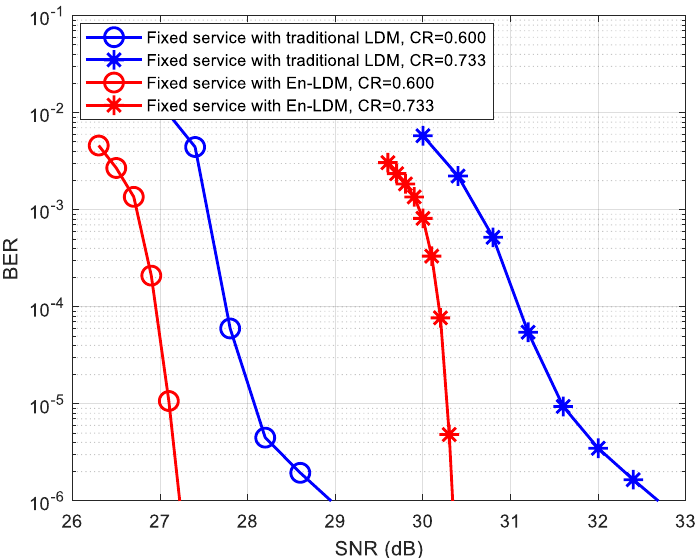
Figure 11. BER performance of fixed service with En-LDM and traditional LDM systems in the multipath channel under different code rates, where the injection level was set to ∆ = 12 dB, the CL constellation was set to QPSK, the EL constellation was set to NU−64QAM, the puncturing rate of En-LDM scheme was set to 1/13, and the LDPC code rates of EL were set to CR = 9/15 and 11/15.